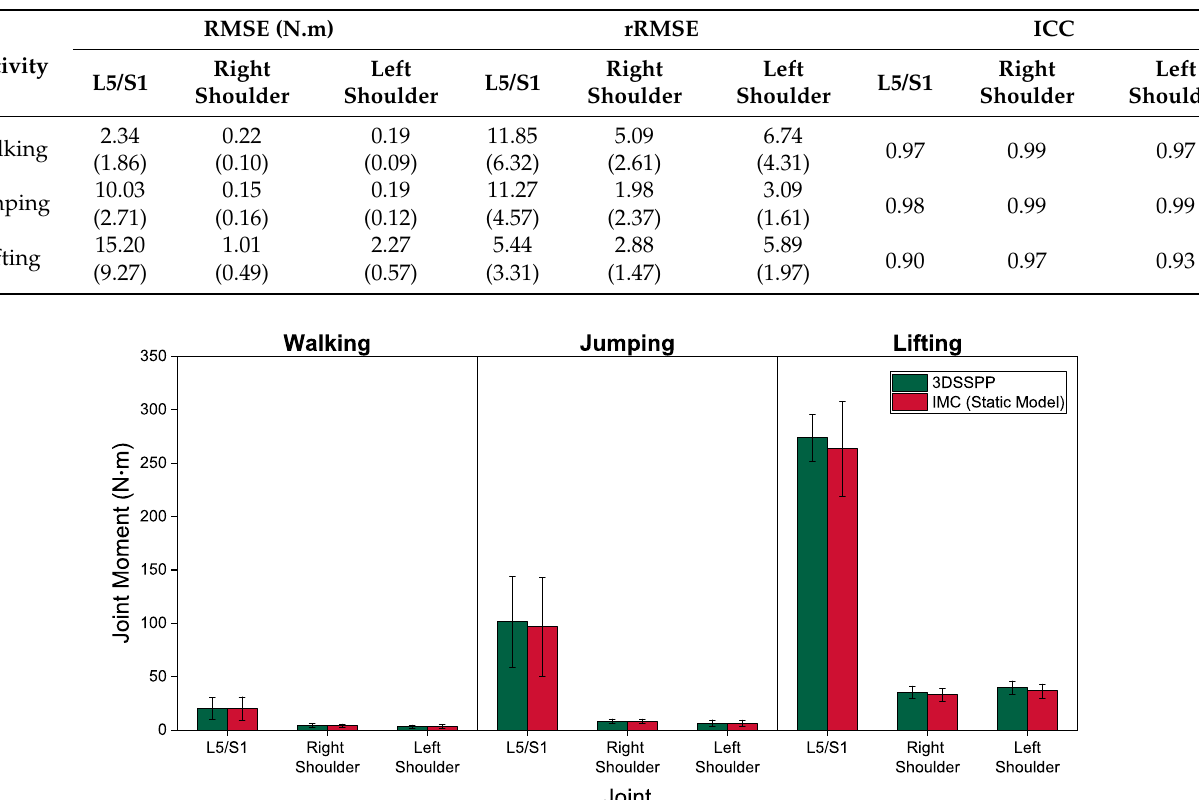
Figure 9. Average peak 3DSSPP-calculated (green bars) and IMC model-predicted (red bars) net static moments of L5/S1, right, and left shoulder joints during walking, jumping, and lifting.